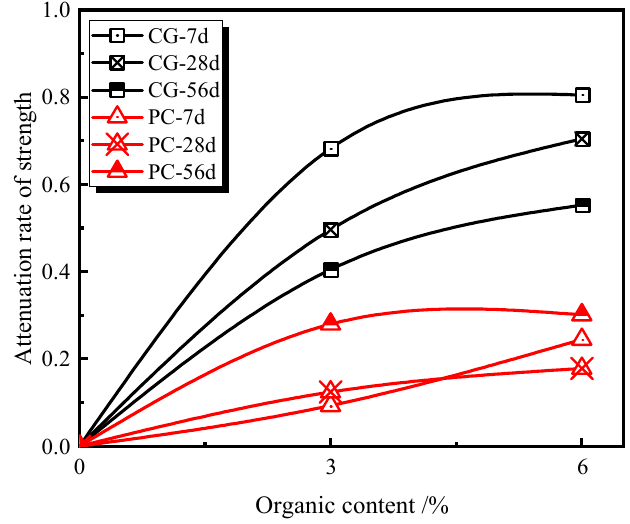
Figure 8. Strength attenuation rate of CG/PC-stabilized soils.